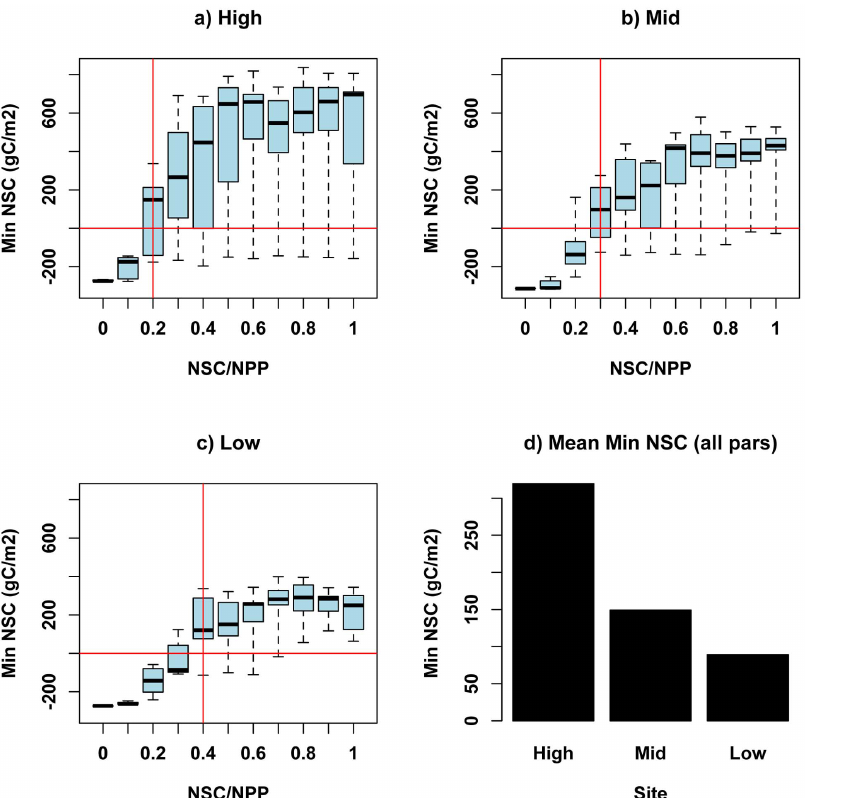
Figure 5. Estimates of minimum NSC over 1992 – 2007 simulation period for high, mid and low elevation stands. Graphs show variation in minimum NSC estimates across variation in parameters: NSC/NPP (x-axis) and MinL/AGC (box widths). Horizontal lines denote values of NSC below which mortality is likely. Vertical line denotes value of NSC/NPP parameter for which minimum NSC is greater than zero for most values (3 rd quartile) of MinL/AGC . This value of NSC/NPP is 0.28, 0.32, 0.38 for high, mid and low sites respectively. Bottom right graph shows average value of minimum NSC across all parameters for high, mid and low elevation sites. Results are based on simulations using carbon storage initialized through 100 yr